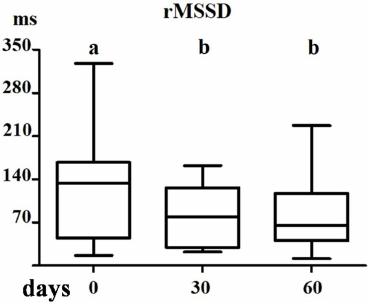
Figure 6. Comparison between mean values in milliseconds (ms), as a function of days, regarding rMSSD value, before and after rhinoplasty surgery. Different letters (“a” and “b”) along the one of the columns indicate significant difference at 5%